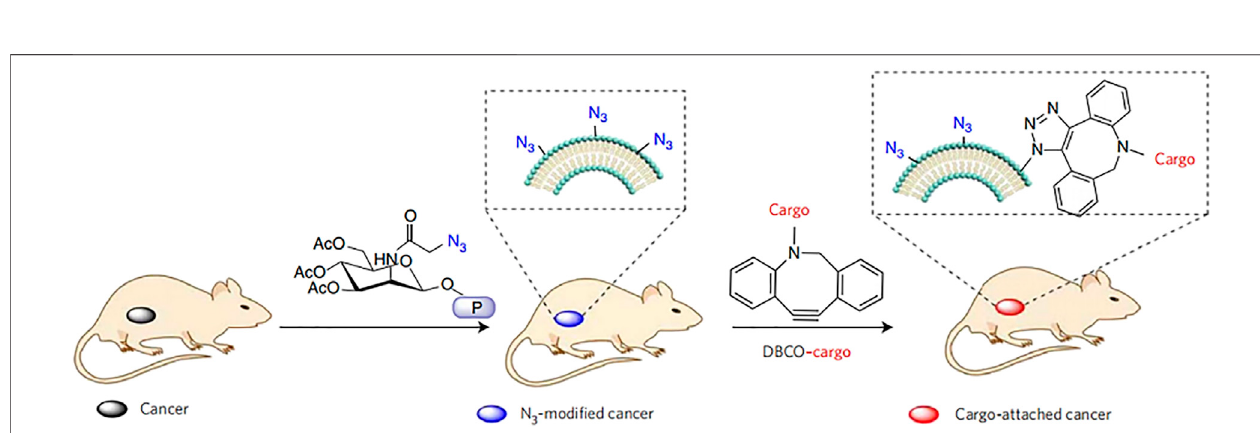
FIGURE 5 | Active tissue targeting via anchored click chemistry technology: in vivo selective labeling of cancer cells with azido groups and subsequent cancer targeting via ef fi cient click chemistry (Reproduced from Wang et al., 2017).